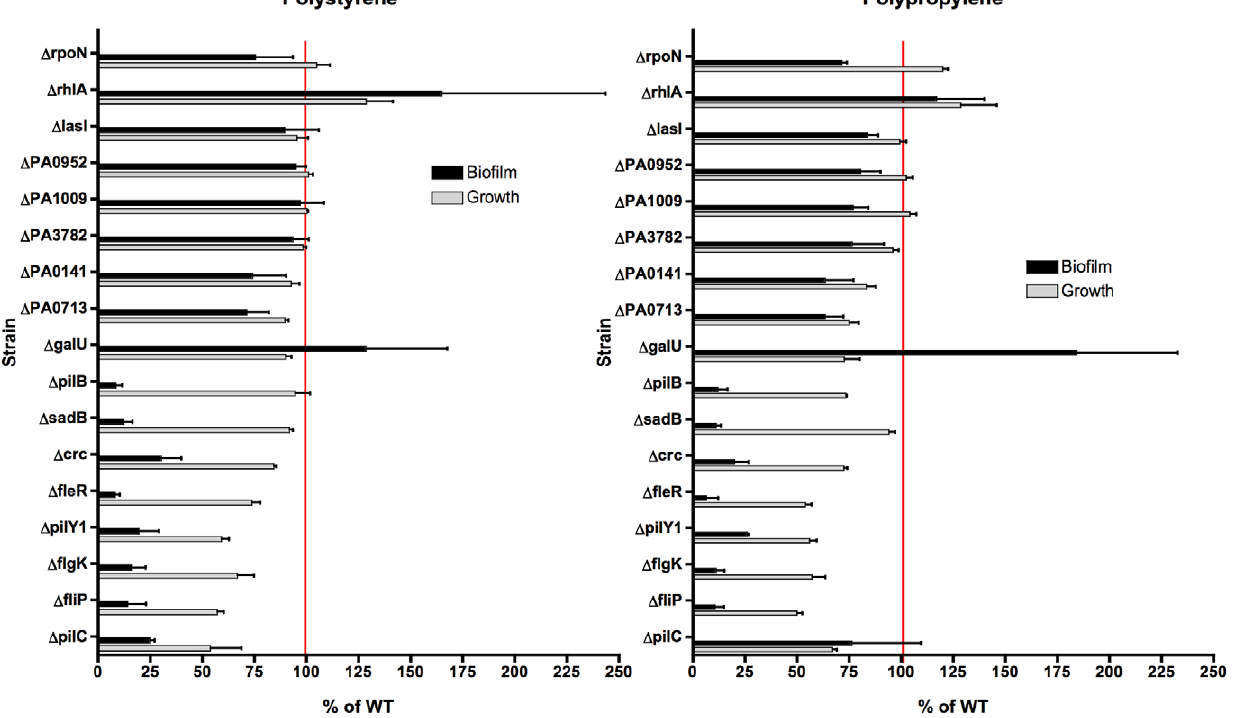
Figure 2. Microtiter Plate Biofilm Assay. P. aeruginosa wild-type strain PA14 and the listed mutants (obtained from a non-redundant PA14 transposon-insertion mutant library) were incubated in 96-well microtiter plates with different substrates (polystyrene and polypropylene) for 12– 14 hours at 37 u C. Growth was measured by spectrophotometry (OD 630 ). To assess biofilm formation, microtiter plates were then emptied, washed with sterile 0.9% normal saline, incubated with 1% crystal violet for 15 minutes at RT, then destained with 95% ethanol. The results are the means of three separate biological experiments. Each biological experiment contained 7 technical replicates; the mean was obtained for each biological experiment. The red line indicates biofilm and growth rate for wild-type strain PA14 (100%